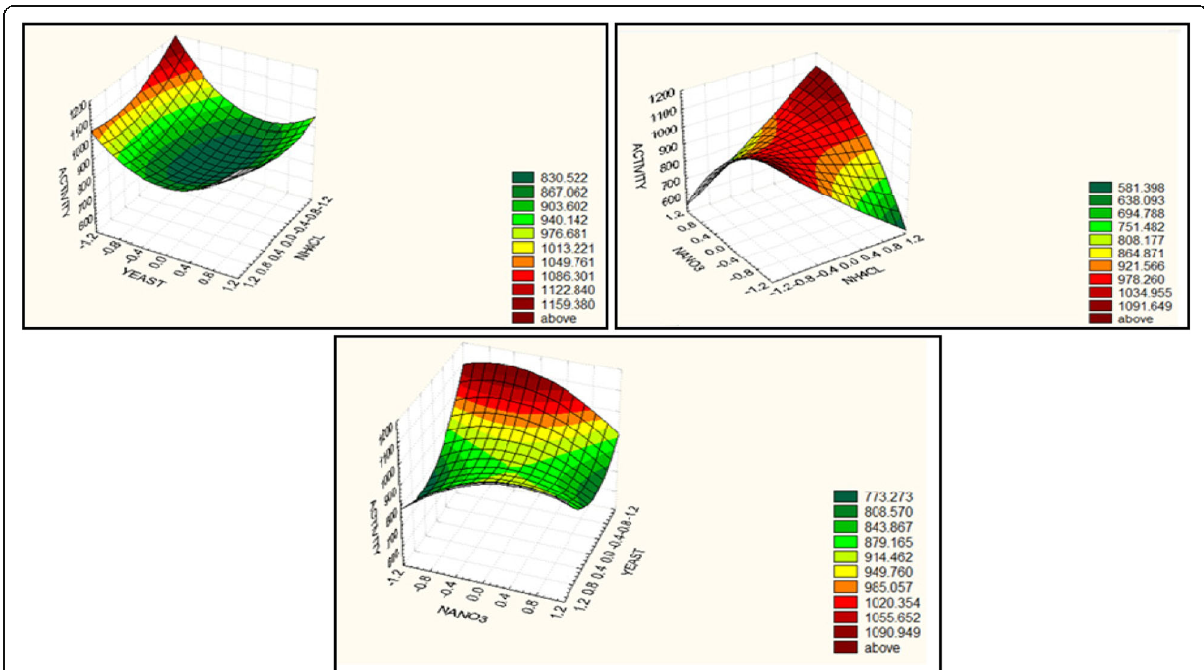
Fig. 2 Three-dimensional response surface representing protease with keratinolytic activity yield (U/ml) from Laceyella sacchari strain (YNDH) as affected by culture conditions